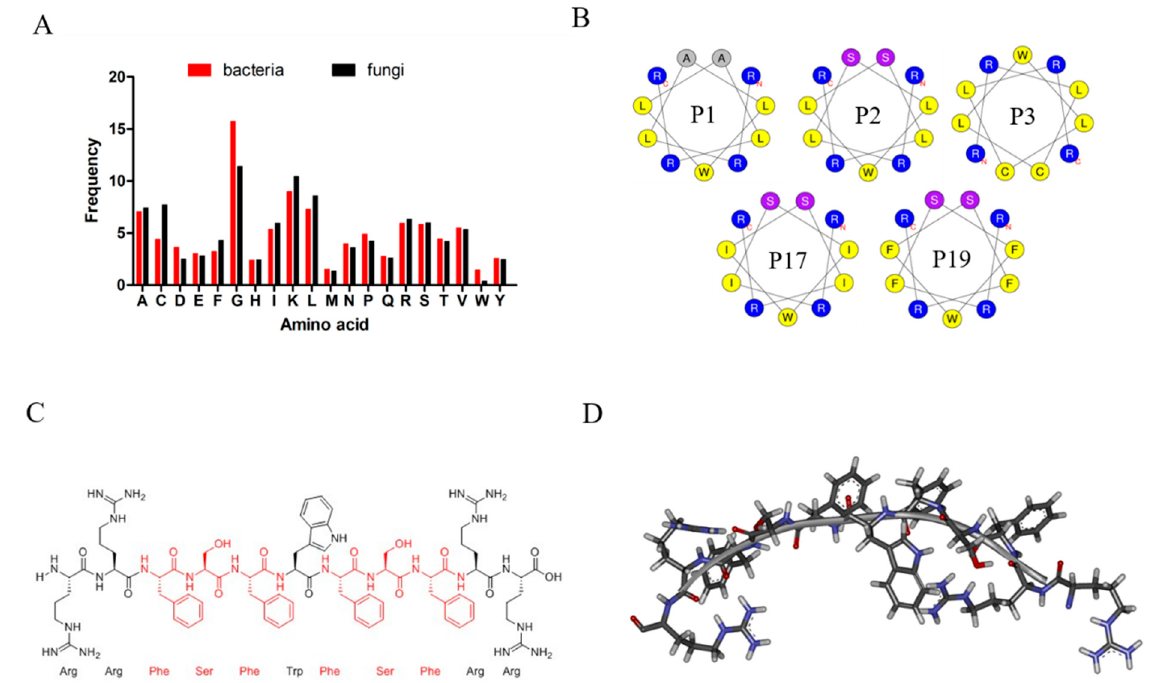
Scheme 1. Comparison of the amino acid distribution of peptides against bacteria and fungi ( A ); Helical wheel projections of the five peptides ( B ); General schematic of P19 ( C ); Three-dimensional structure projections of the potential central- symmetric peptide ( D ).